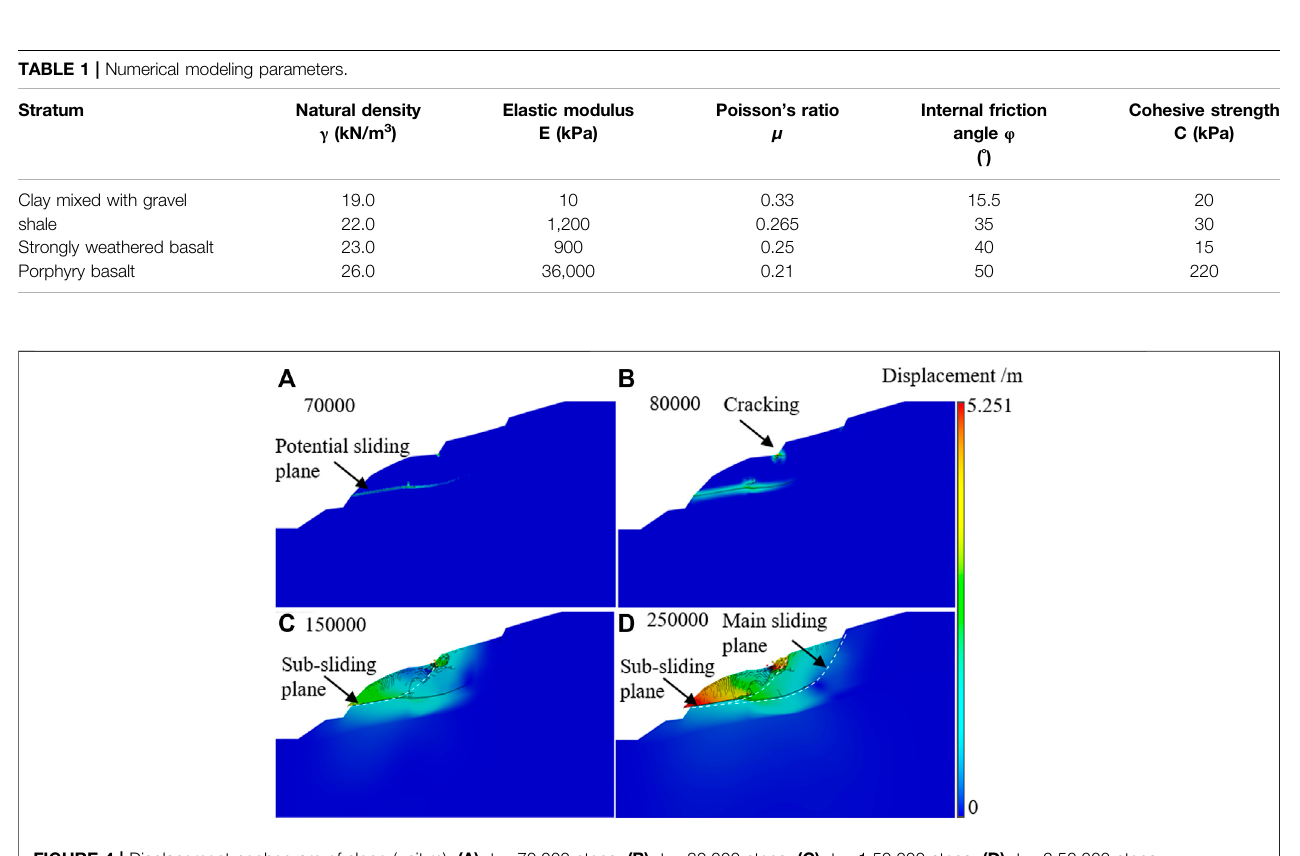
FIGURE 4 | Displacement nephogram of slope (unit:m). (A) : t = 70,000 steps, (B) : t = 80,000 steps, (C) : t = 1,50,000 steps, (D) : t = 2,50,000